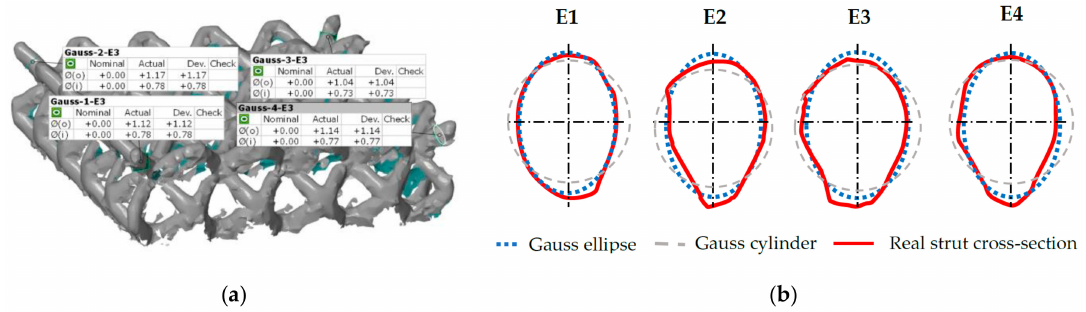
Figure 15. Comparison of the real and ideal cylinder cross-section: ( a ) shape analysis in the GOM Inspect software and ( b ) real cross-section in four corner struts.